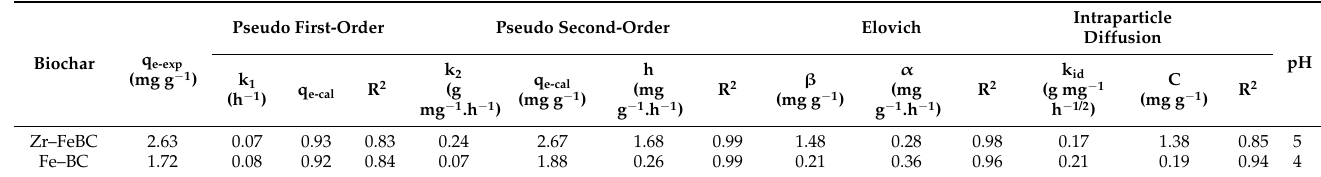
Table 2. The parameters of the kinetics model for P